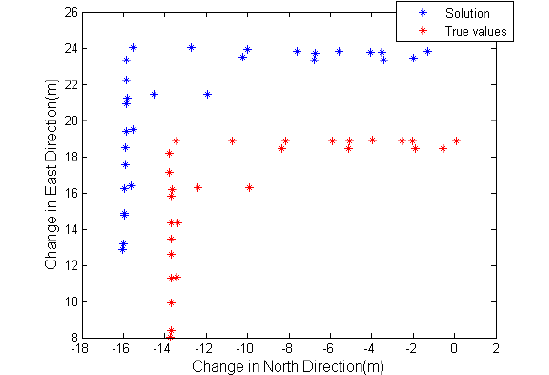
Figure 11. Mapping solution without using any control